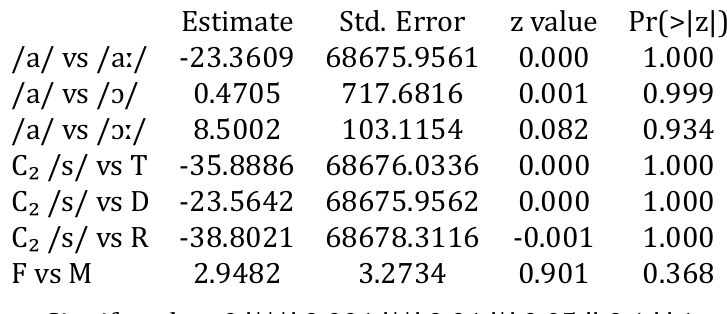
Table A.9: Post-aspiration occurrence of C₁ /s/ as a dependent variable